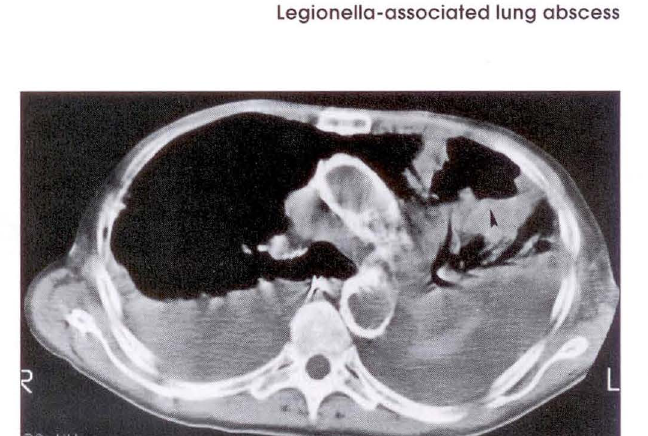
Figure 2a) Computed tomographic scan of the chest of patient 2 obtained on the seventh hospital day showing an abscess cavity (aTTow) with an area of lingular consolidation and large bilateral pleural effusions